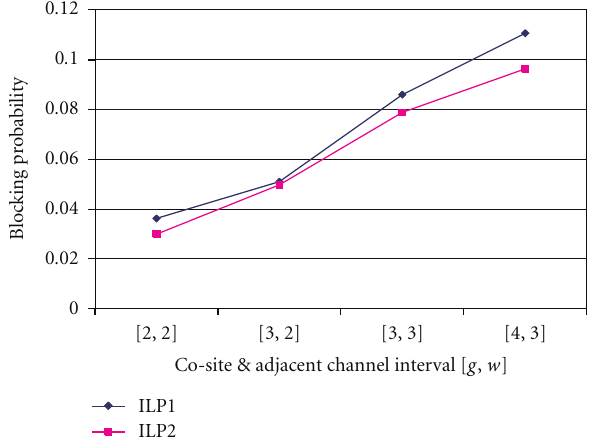
Figure 11: Performances of ILP1 versus ILP2 for ratio 49 :21 with initial tra ffi c